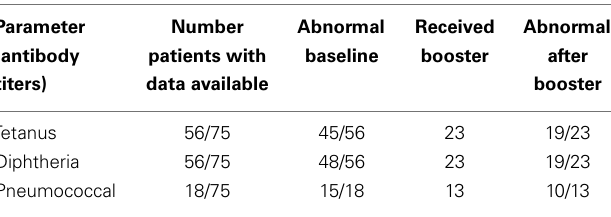
Table 5 | Recorded specific antibody titers in patients with abnormal bacteriophage results ( n = 75) a